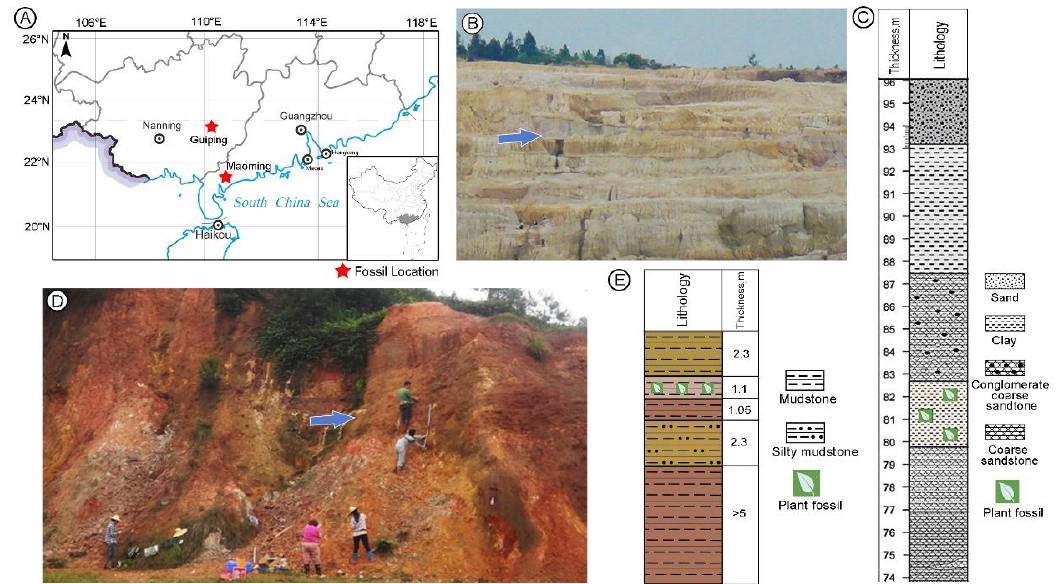
Figure 1. The geographic location, and stratigraphic sections of two fossil sites, one in the Maoming Basin and one in the Guiping Basin, South China. ( A ) Geographical location map of the Maoming and Guiping basins. ( B ) Field photo of lithological characteristics of the Huangniuling Formation, Maoming, the blue arrow indicates the fossil layer. ( C ) Stratigraphic column of the outcrop section in B, the upper part of Huangniuling Formation (modified from Herman et al. [23]). ( D ) Field photo of lithological characteristics of the Erzitang Formation from Guiping, the blue arrow indicates the fossil layer. ( E ) Stratigraphic column of the outcrop section in D (modified from Huang et al. [24]).